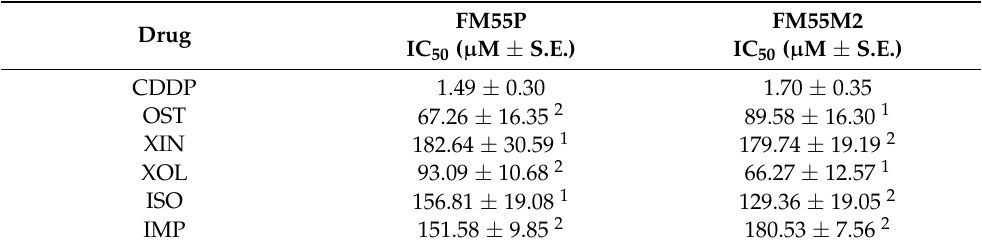
Table 1. Antiproliferative effect of cisplatin (CDDP) and 5 naturally occurring coumarins (osthole (OST), xanthotoxin (XIN), xanthotoxol (XOL), isopimpinellin (ISO), and imperatorin (IMP)) adminis- trated singly in the FM55P and FM55M2 melanoma cell